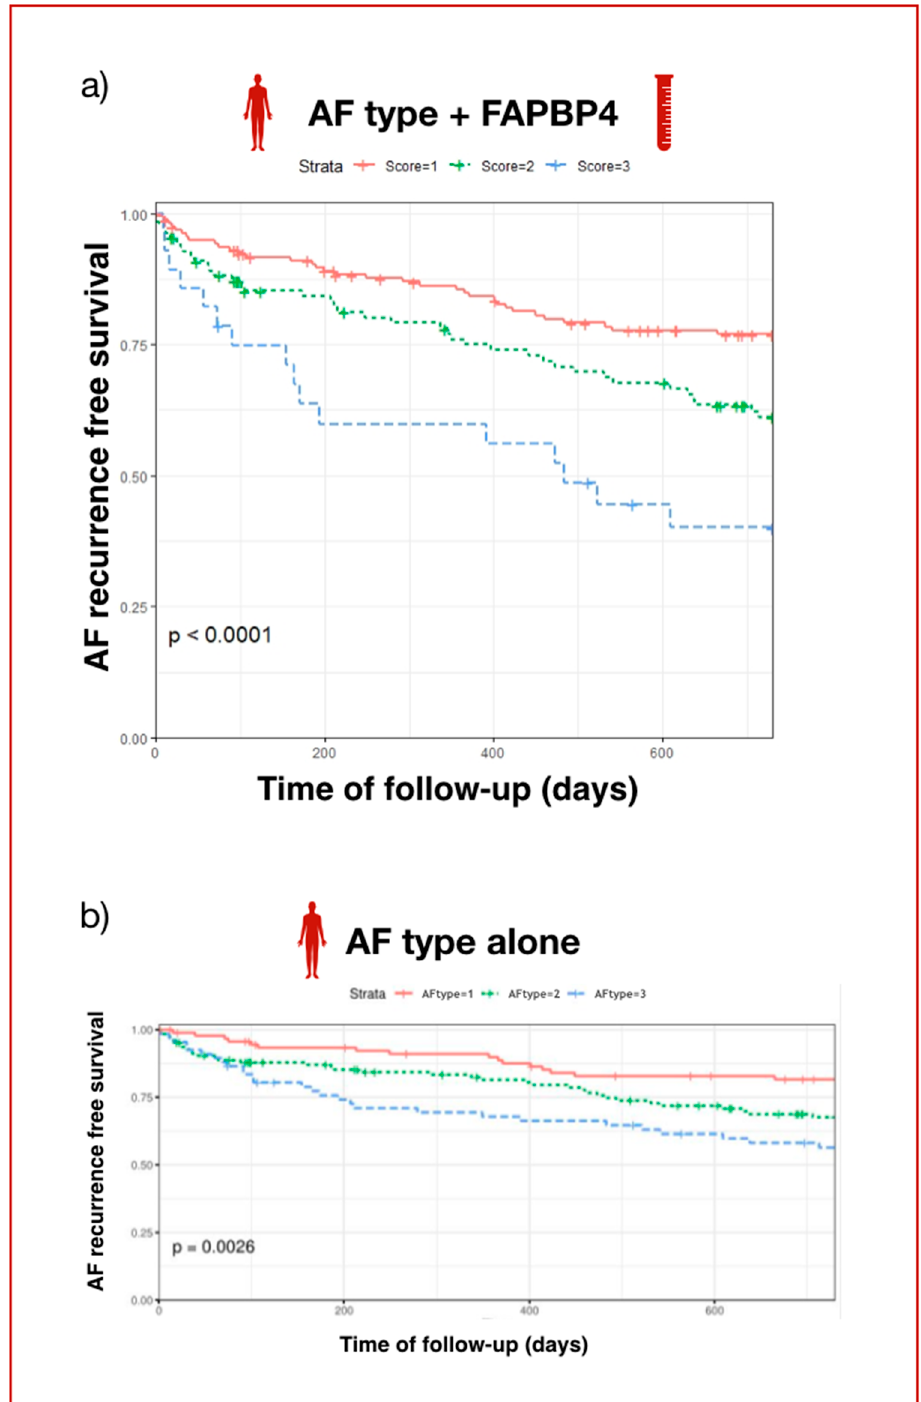
Figure 1. Kaplan–Meier curves estimating freedom from atrial fibrillation after pulmonary vein isolation: ( a ) considering AF type and FABP4 levels (proposed score). ( b ) considering only AF type (1: paroxysmal; 2: persistent; 3: long-standing persistent). Table 4. Cox regression model with AF recurrence as dependent variable.